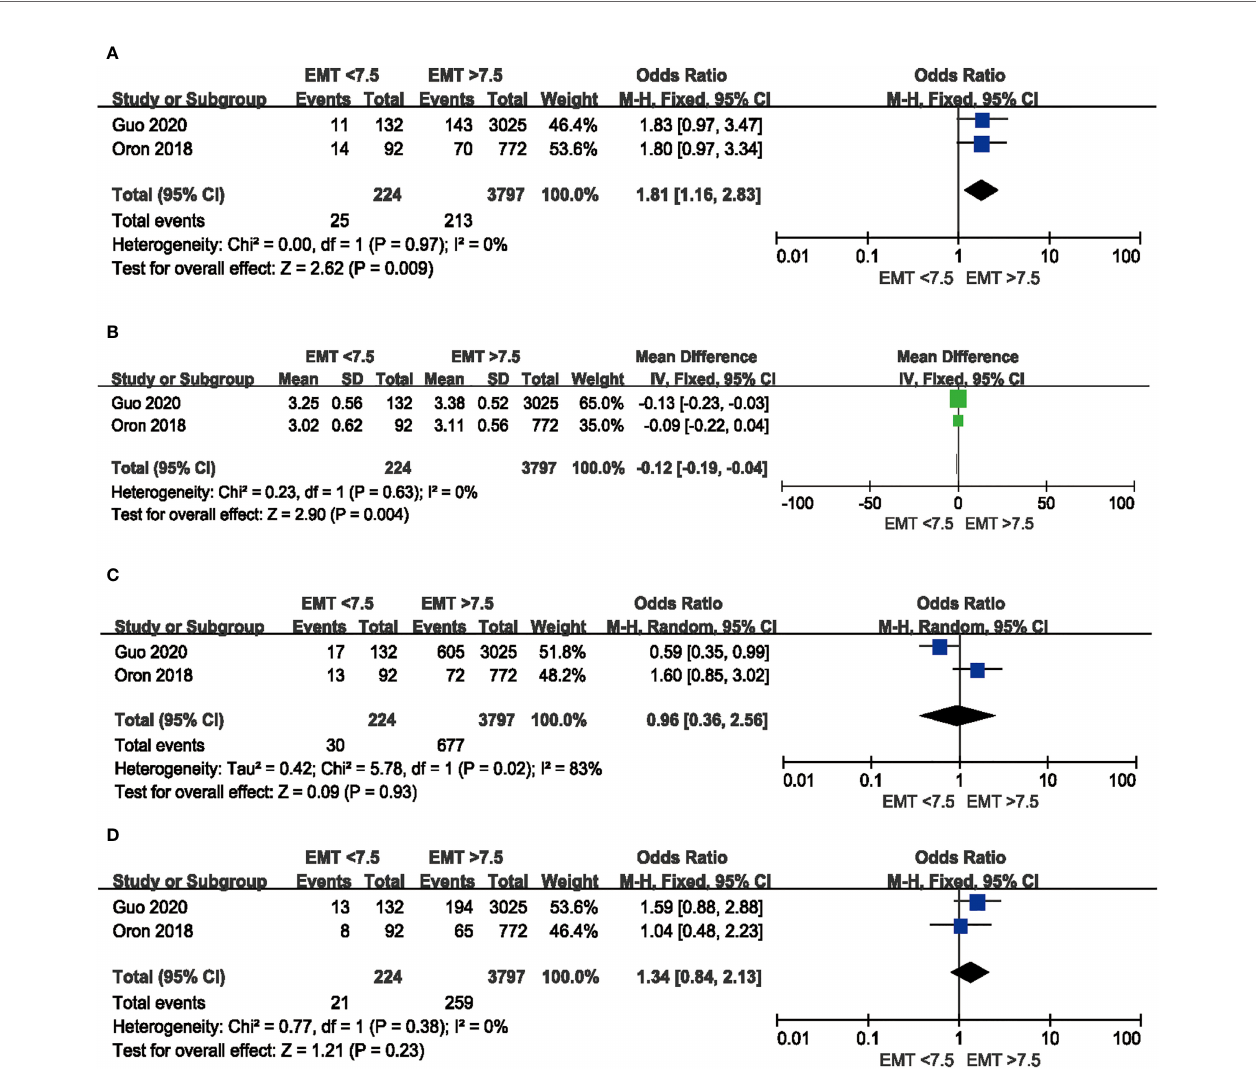
FIGURE 7 | Comparison of perinatal outcomes between EMT <7.5 mm and EMT >7.5 mm in fresh cycles. (A) Comparison of SGA between thin endometrium group and non-thin endometrium group. (B) Comparison of BW between thin endometrium group and non-thin endometrium group. (C) Comparison of LGA between thin endometrium group and non-thin endometrium group. (D) Comparison of PTD between thin endometrium group and non-thin endometrium group. SGA, Small-for-gestational-age; BW, Birthweight; LGA, Large-for-gestational-age; PTD, Preterm